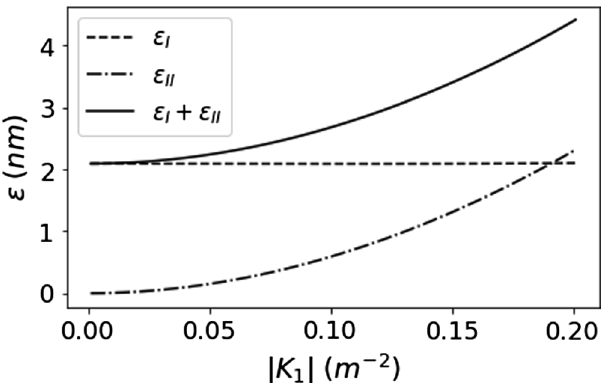
FIG. 3. The correlation between the transverse emittances and the skew quadrupoles ’ strength j K 1 j . The vertical emittance (the dot-dash line) grows faster than the reduction of the horizontal emittance (the dashed line). The total emittance is not constant when the coupling becomes strong, which leads to the breakdown of Eq. (1).